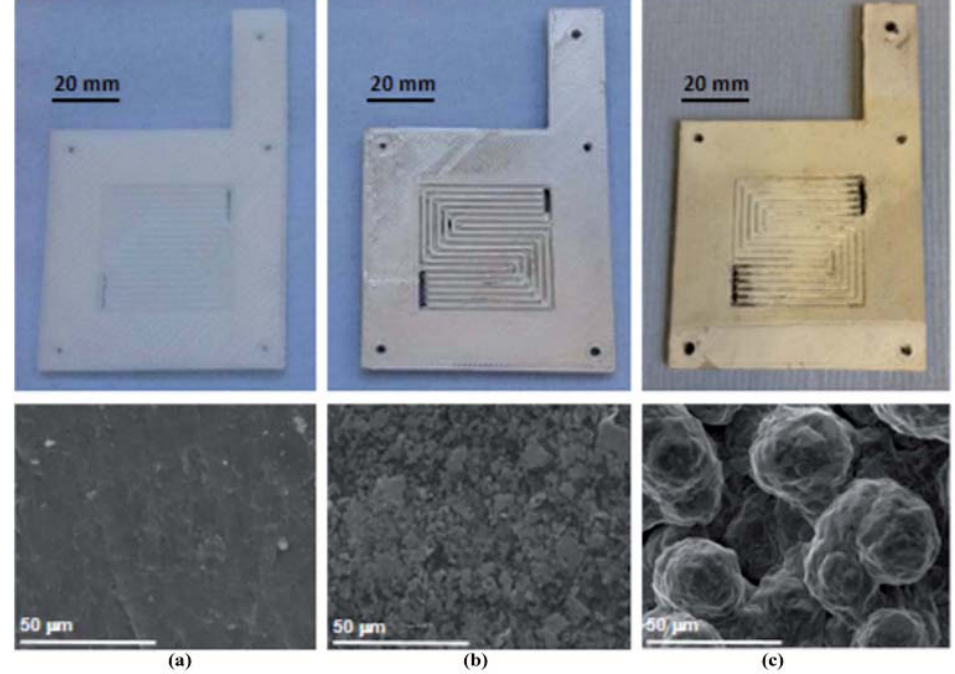
Figure 6. (Chisholm et al.) Photographs and relevant scanning electron microscopy (SEM) images of polypropylene (PP) flow plates. ( a ) Uncoated PP; ( b ) Curing of the second coat of silver paint; ( c ) Electrodeposition of silver. (Reproduced with permission from [26].)